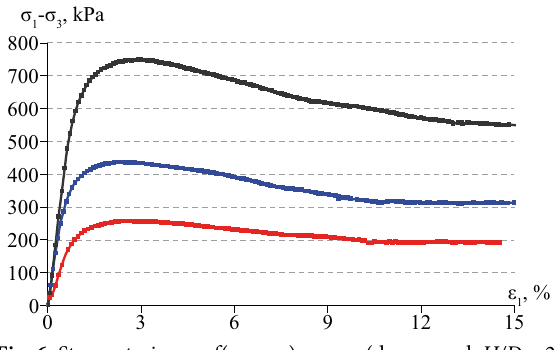
Fig. 6. Stress-strain ε 1 = f(σ 1 – σ 3 ) curves (dense sand, H/D = 2): – 50 kPa; – 100 kPa; – 200 kPa